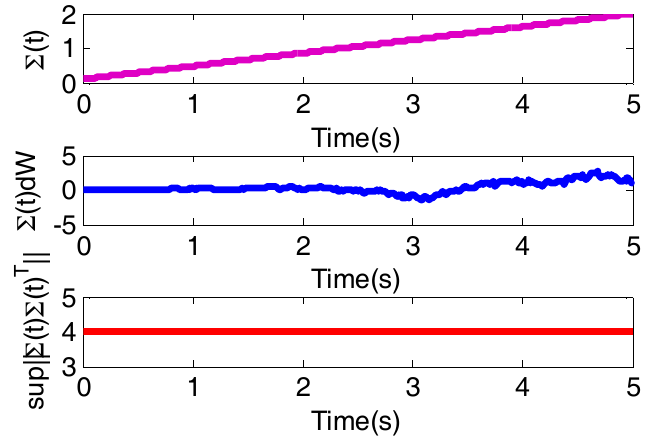
Figure 1. Three models of uncertainty. ( Top ) The change of Σ ( t ); ( Middle ) The Wiener Process model Σ ( t ) dW ; ( Bottom ) The model sup|| Σ ( t ) Σ ( t ) T ||.